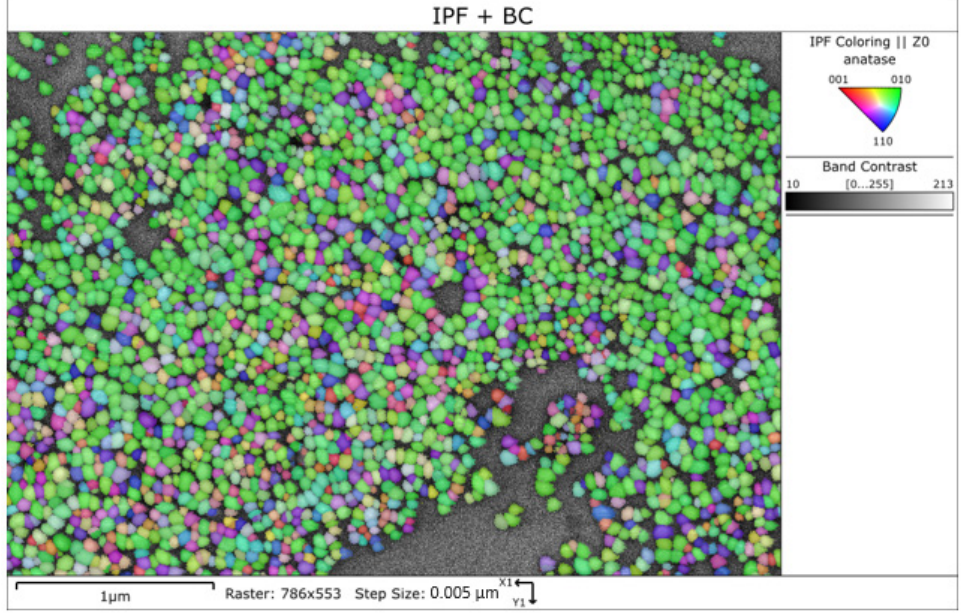
Figure 10. Inverse pole figure (IPF) with overlaid band contrast of TKD mapped TiO 2 NPs. A TKD map only with highlighted particles lying on a {101} facet is shown in Figure S4 together with the pole figures of the selected subset. A total number 474 TiO 2 NPs are lying on a {101} facet (within 10° range around perfect {101} parallel to the carbon surface orientation) on the carbon film. The TKD map highlighting only those particles lying on a {100} facet is shown in Figure S5 together with the pole figures of the corresponding subset. A total number of 545 particles are lying on a {100} facet (within 10° range around